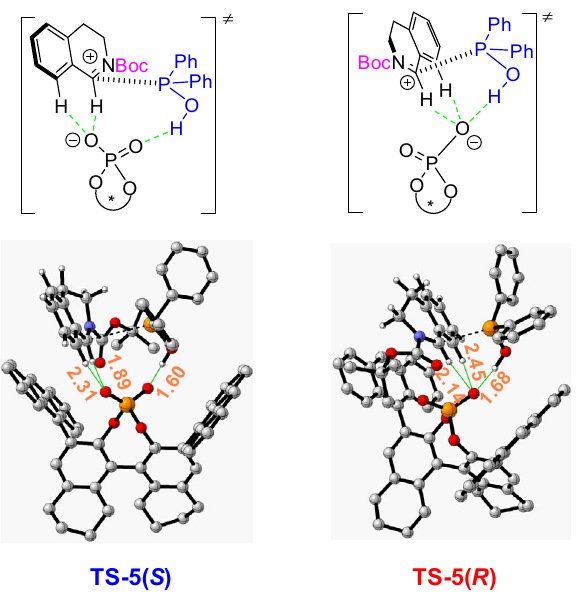
Fig. 7 Structures of transition states of phosphinylation of the isoquinolinium. Bond distance is given in Å. Unimportant H atoms are omitted for clarity.